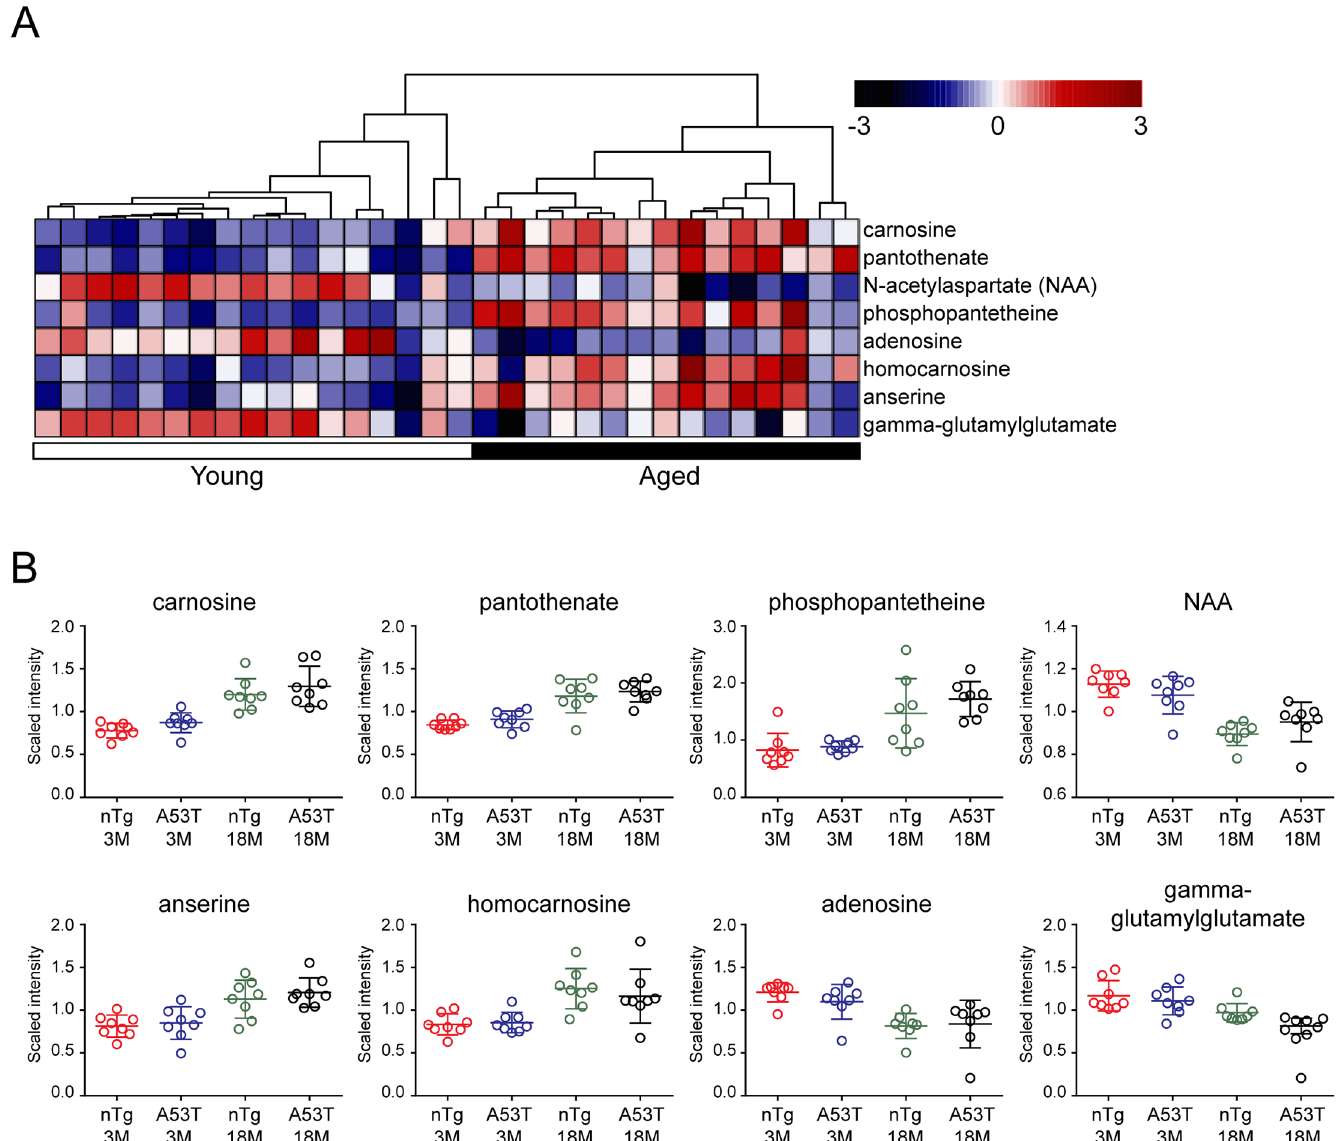
Fig 4. Identification of Aging-related metabolite biomarker. (A) Two-way ANOVA test (q value < 0.05) and RF analysis (Mean decrease accuracy > 5) identify eight metabolites significantly affected by aging. Unsupervised hierarchical clustering plot shows the segregation between aged and young samples. The scaled intensity of eight metabolites is relatively depicted according to the color key shown on the top. Red indicates high intensity levels; blue, low intensity levels. The q-value used here represents the measurement of the proportion of false positives incurred (also called the false discovery rate). (B) Scatter plots compare the scaled intensity of those eight metabolites from different sample groups.